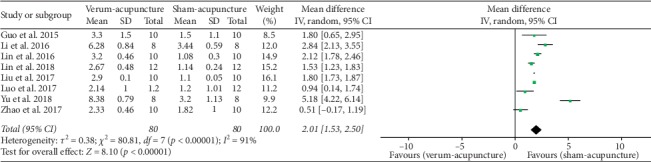
Forest plot of verum- versus sham-acupuncture in platform crossover numbers.